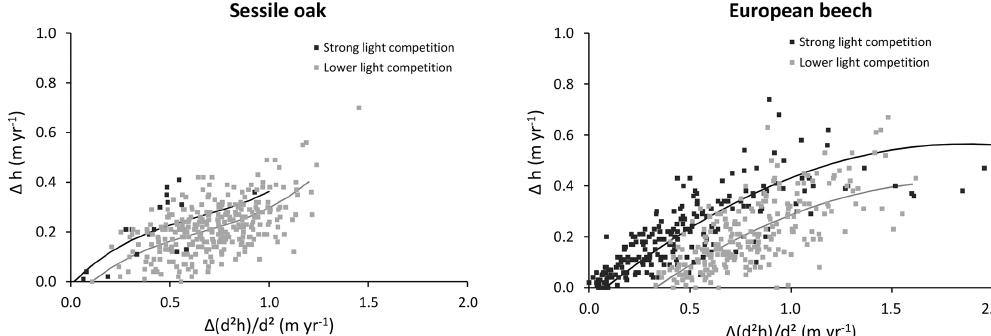
Figure E1. Effect of the height growth potential on oak and beech height growth for two levels of light competition (strong light competition = light competition index ≤ 0.15, lower light competition = light competition index > 0.15). The solid lines represent the model predictions obtained using Eq. (31) with parameter values of Table E1 and with mean values for dbh, height or the light competition index.